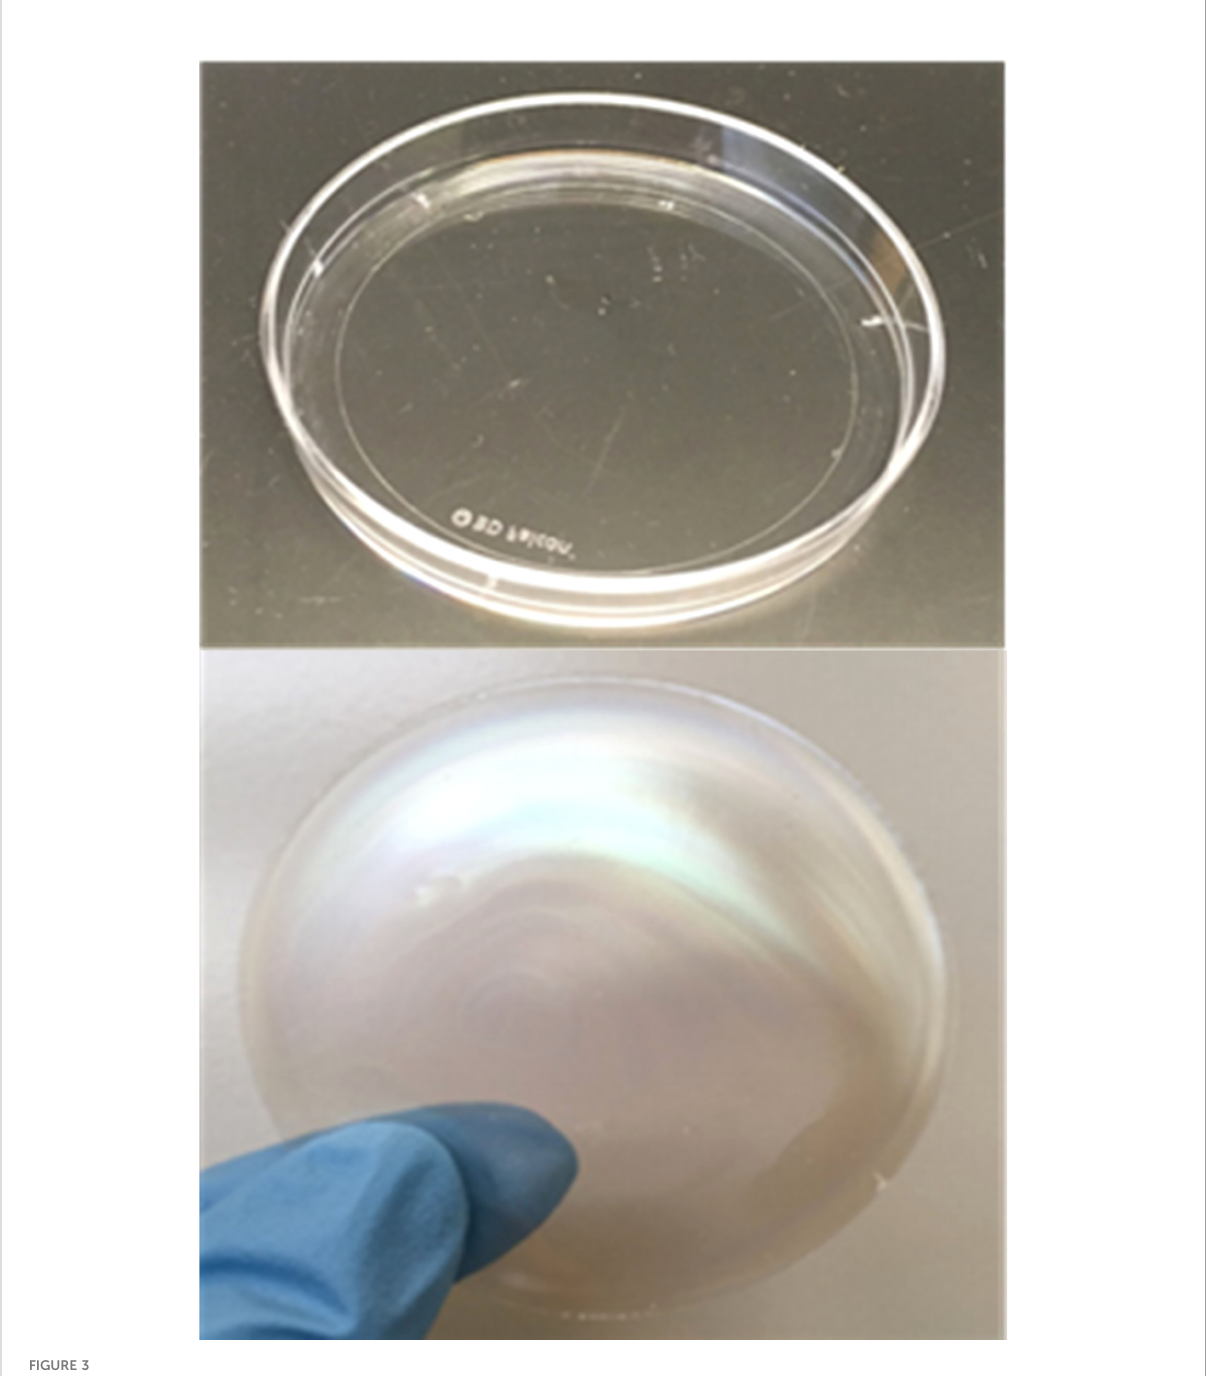
FIGURE 3 Example of wet cellulose nanocrystal dispersion evaporating in the Petri dish (top) and remaining cellulose nanocrystal fi lm remaining after evaporation